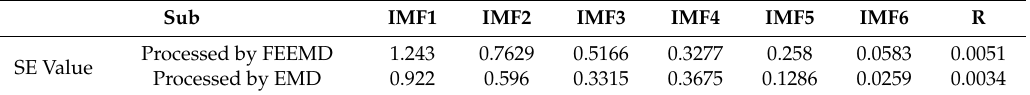
Figure A1. ( a ) The FEEMD decomposition result of the Hubei carbon price; ( b ) The EMD decomposition result of the Hubei carbon price; ( c ) The FEEMD decomposition result of the Shenzhen carbon price; ( d ) The EMD decomposition result of the Shenzhen carbon price. Table A1. The results on the SE values of the Shenzhen carbon price decomposition.